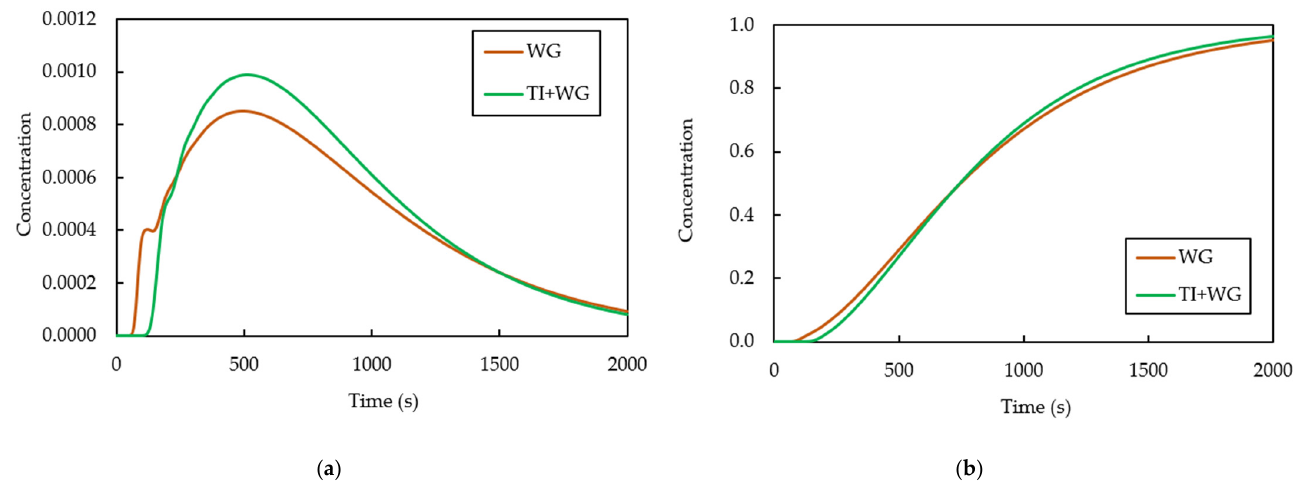
Figure 14. ( a ) E-curve and ( b ) F-curve for multiphase tundish configurations: WG and TI + WG. Table 5. Computational RTD parameters and the volume fraction of flow for the cases WG and TI + WG. Case